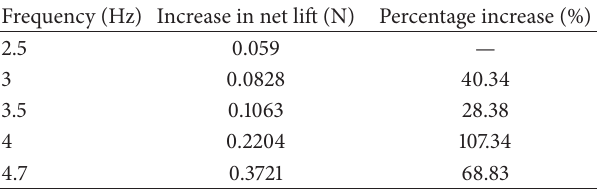
Table 2: Enhancement in net lift using ventilated wing compared to solid